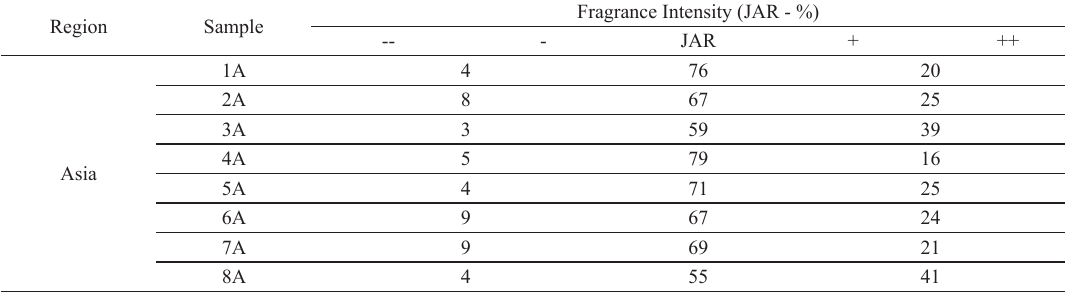
Table 5. Sensorial analysis of the attribute ‘fragrance intensity’ for products in Asia. Region